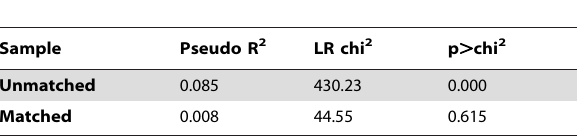
Table 5. Significance of overall model.